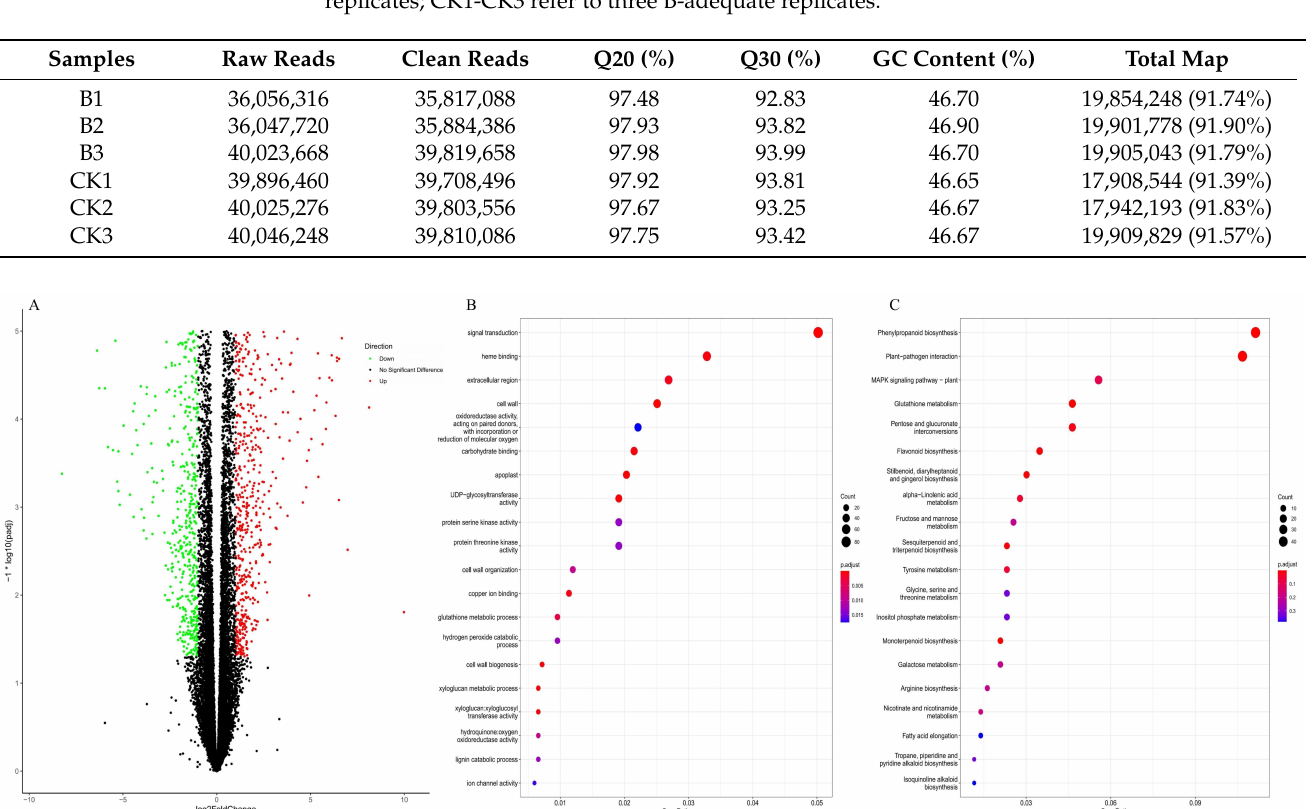
Figure 2. JA ( A ) and ABA ( B ) content in P. betulaefolia root under B-deficient conditions. Values are means of three replicates ± SE. Bars with different letters indicate significant differences at p < 0.05. Table 1. Summary of transcriptome sequencing data of all libraries. B1–B3 refer to three B-deficient replicates; CK1-CK3 refer to three B-adequate replicates.